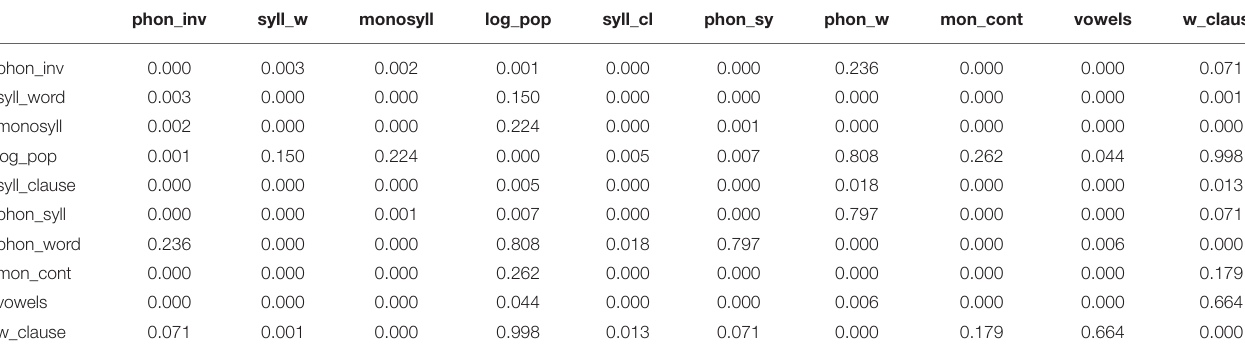
TABLE 1 | p -values of the correlations between the linguistic variables and log population